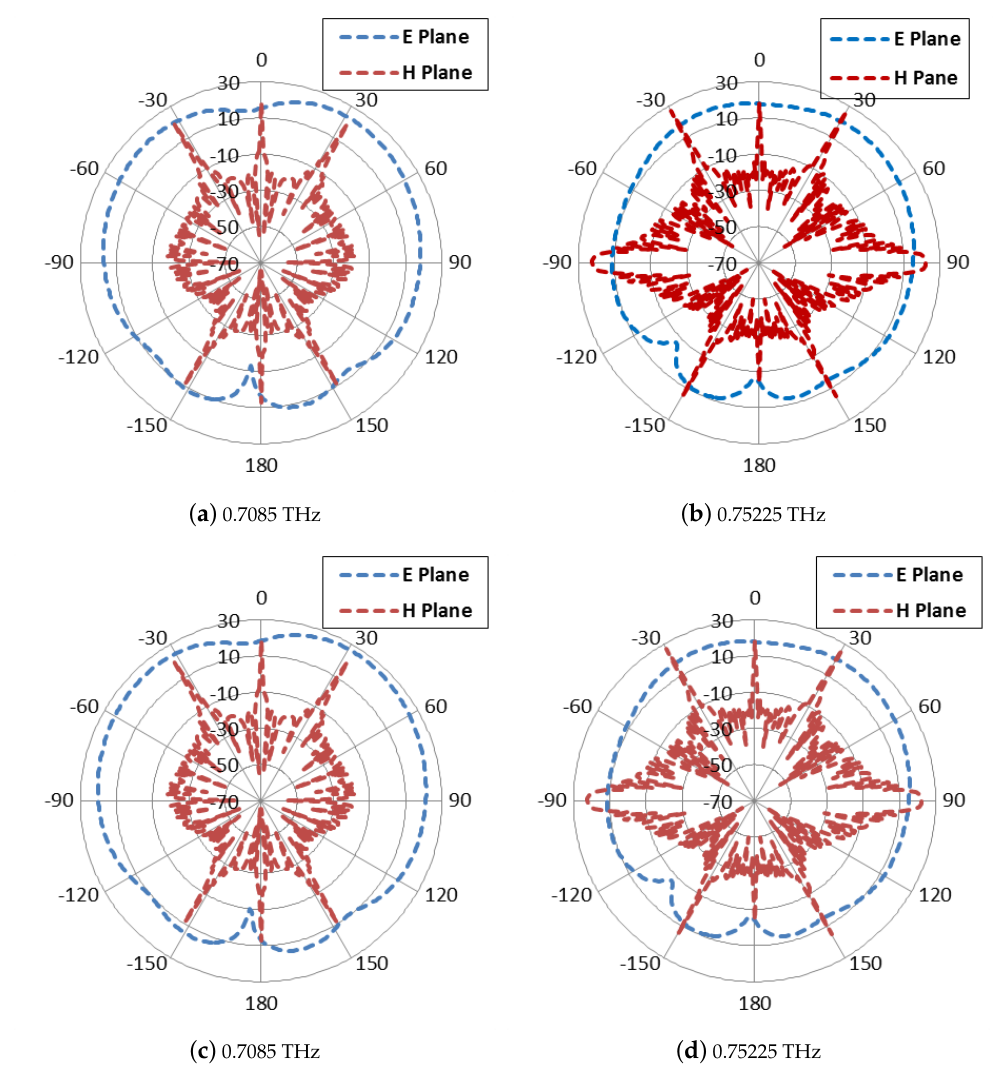
Figure 16. Comparison of polar plots for dual-band Type D and Type E THz antenna array. ( a ) Type D antenna array at 0.7085 THz ( b ), Type D antenna array at 0.75225 THz, ( c ) Type E antenna array at